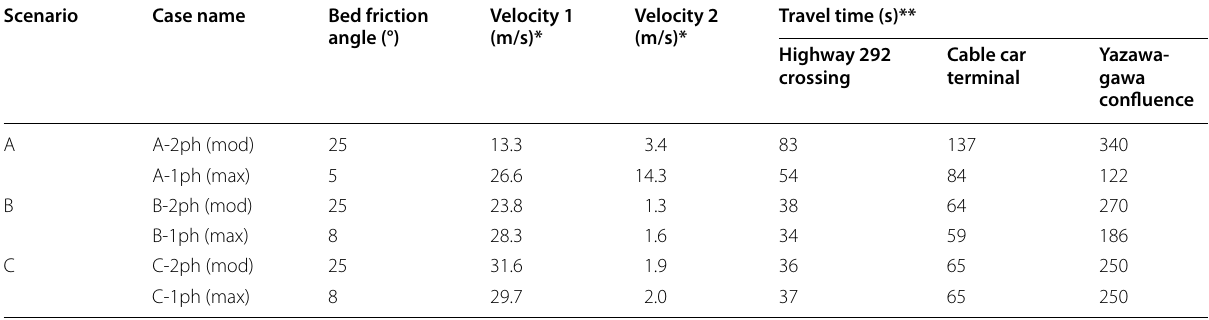
*Velocity 1 and Velocity 2 corresponds to upslope segment and downslope one before and after the breakpoint at ca. 2500 m distance **Travel times show the time when the flow front passes three check points (see the maps of Figs. 11, 12 and 13)